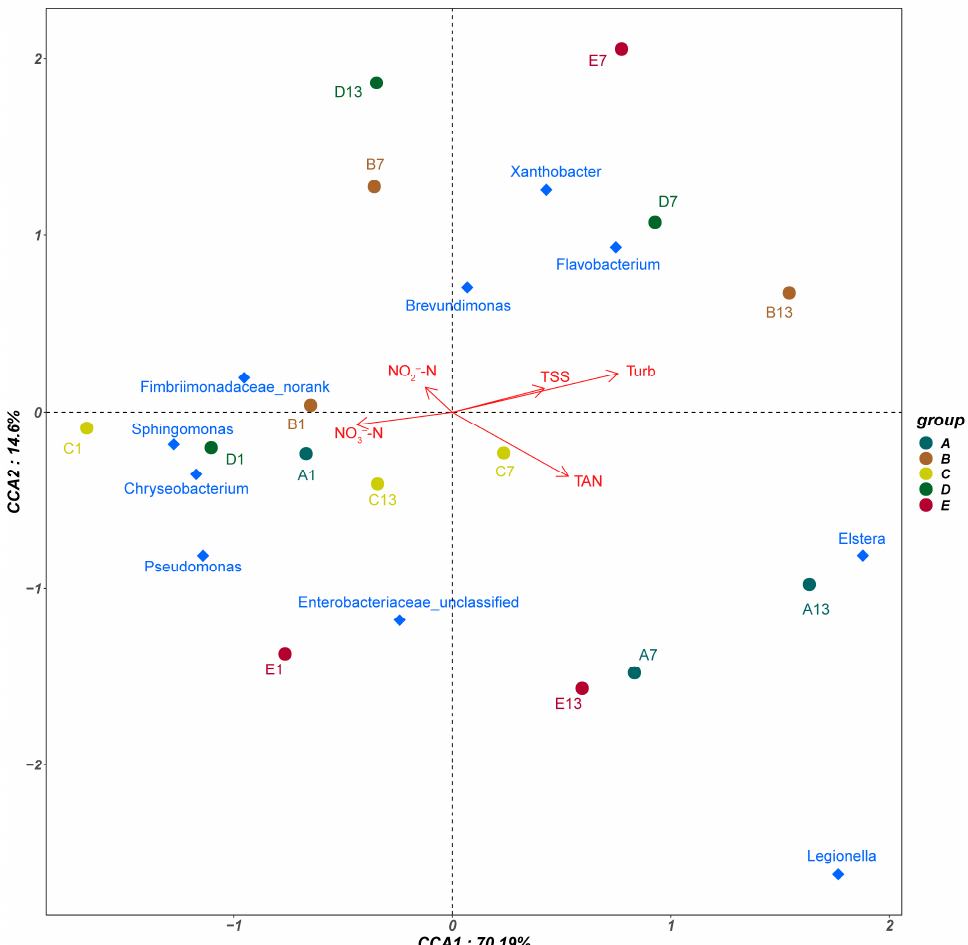
Figure 4. Canonical correspondence analysis (CCA) with water parameters and bacterial community (top 10 dominant at genus level) in biofloc system. TAN, total ammonia nitrogen; NO 2 − -N, nitrite nitrogen; NO 3 − -N, nitrate nitrogen; TSS, total suspended solid; Turb, turbidity. The water parameters were indicated as arrows. The dominant bacteria were represented as lozenges. Samples were indicated as circles, with numbers corresponding to their sampling time.